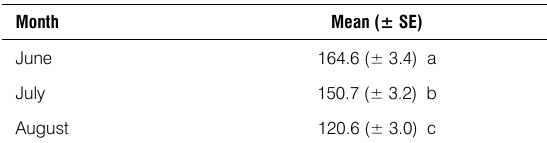
Table 1. Analysis of variance (one-way ANOVA) of emergency calls between months. Values are expressed as mean ± standard error (SE). Values followed by different letters are significantly different according to the LSD test (p < 0.05).